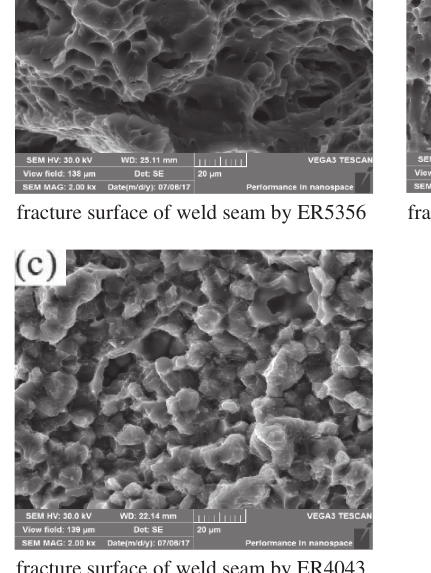
Figure 11: SEM images of the weld joints fracture